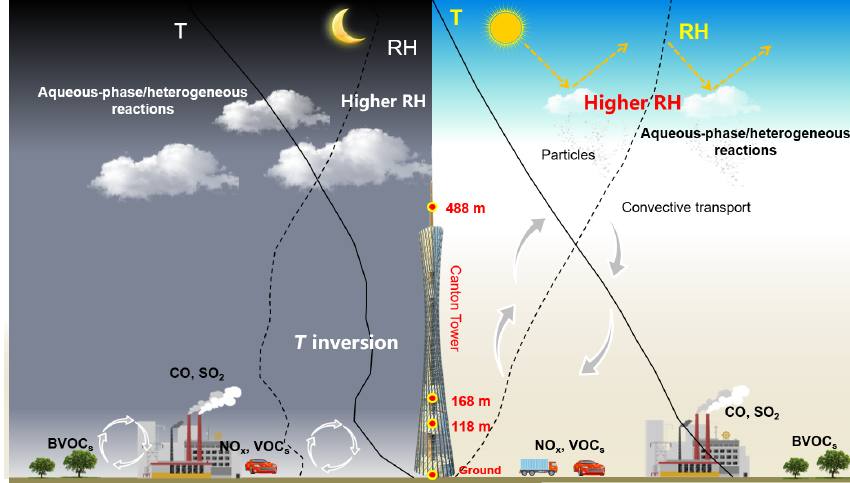
Figure 9. Schematic graph illustrating a typical haze formation mechanism in the PRD region in autumn and winter.